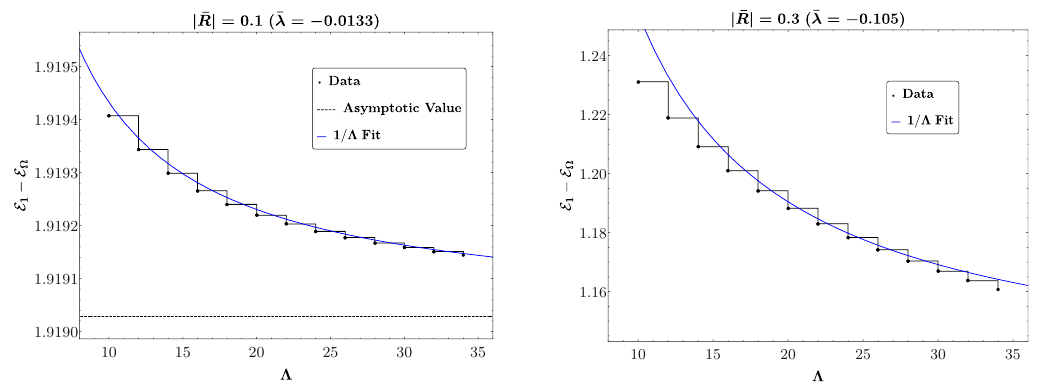
Figure 29. Energy of the first excited state in the Ising model, as a function of the cutoff, for two choices of negative magnetic field, ¯ λ < 0 .